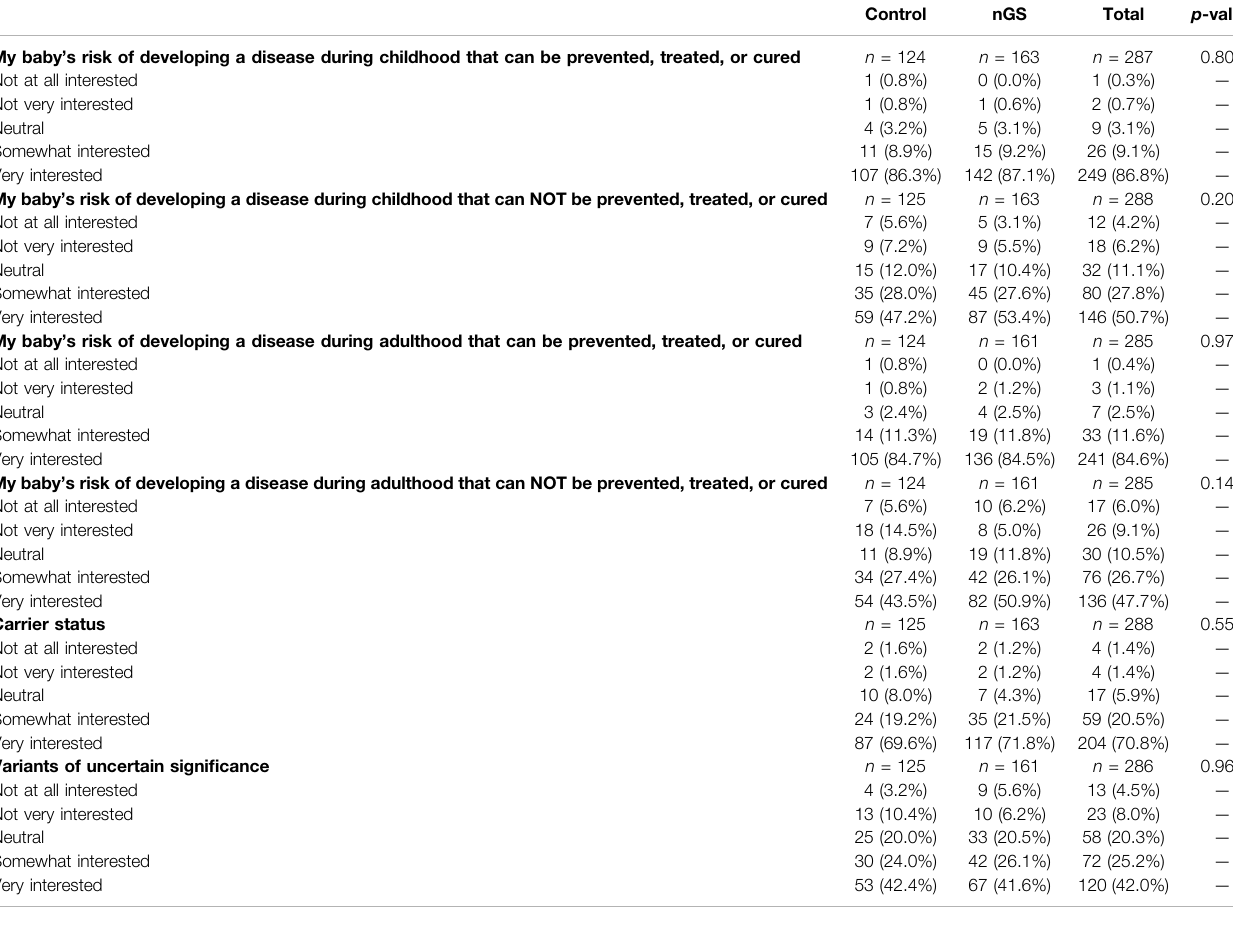
TABLE 4 | Parents ’ attitudes regarding desired results from newborn genomic sequencing by study arm.